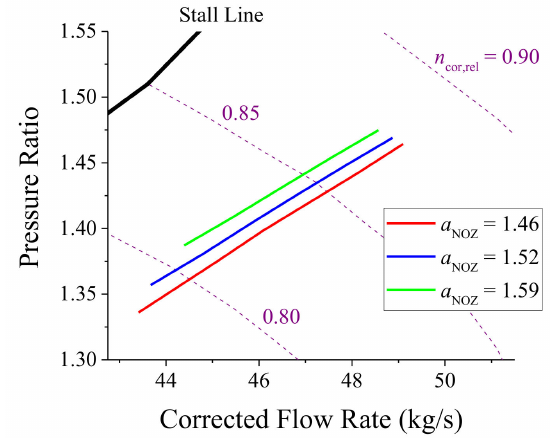
Figure 26. The Variations of the Matched Operating Lines of AFS at the conditions of Different Throat Area Coefficients of Main Nozzle ( α NOZ ).